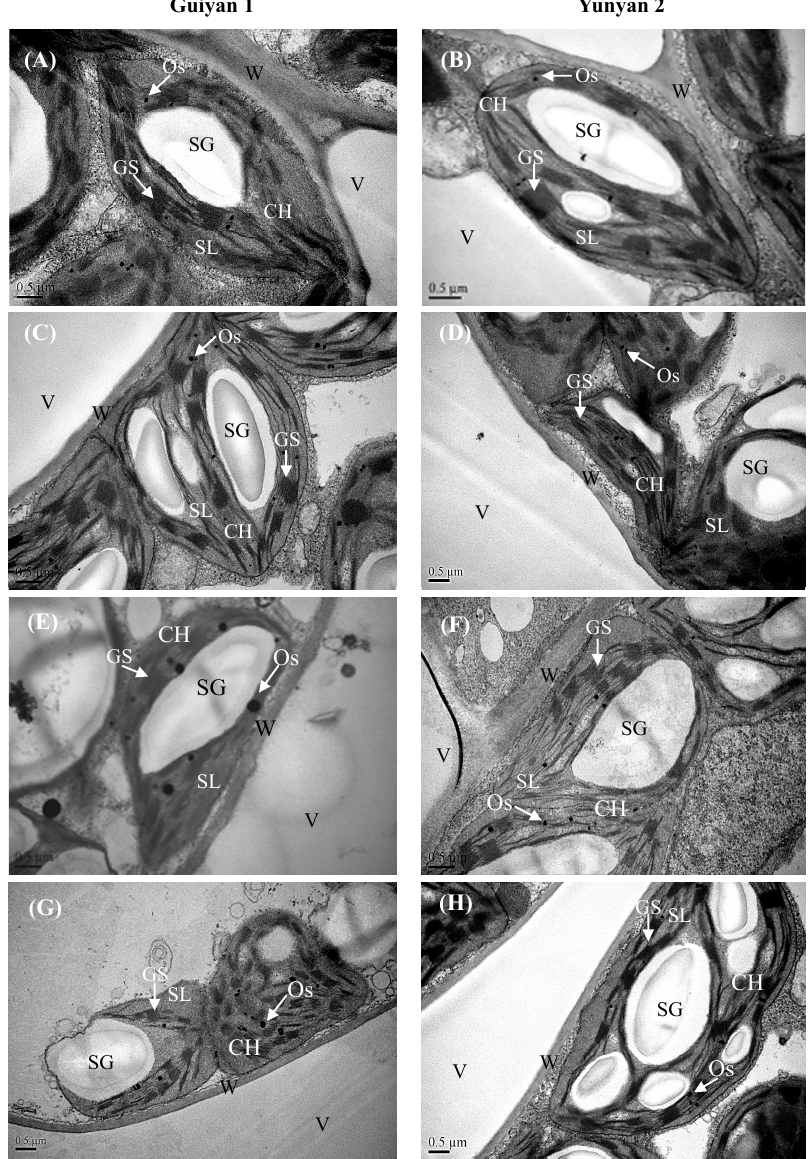
Figure 5. Transmission electron micrograph images of the leaf mesophyll cells of Guiyan1 (left panel) and Yunyan2 (right panel) after 15 days of Control ( A , B ), GB ( C , D ), Cd ( E , F ), and Cd + GB ( G , H ) treatments, respectively. Control, GB, Cd and Cd + GB correspond to BNS + foliar spray of deionized water, BNS + foliar spray of 500 μ M GB, BNS + foliar spray of deionized water + 5 μ M CdCl 2 , and BNS + foliar spray of 500 μ M GB + 5 μ M CdCl 2 , respectively. Labels: CH, chloroplast; GS, grana stack; SL, stroma lamella; Os, osmiophilic plastolobuli; SG, starch grain; V, vacuole; W, cell wall. Bar = 0.5 μ m.